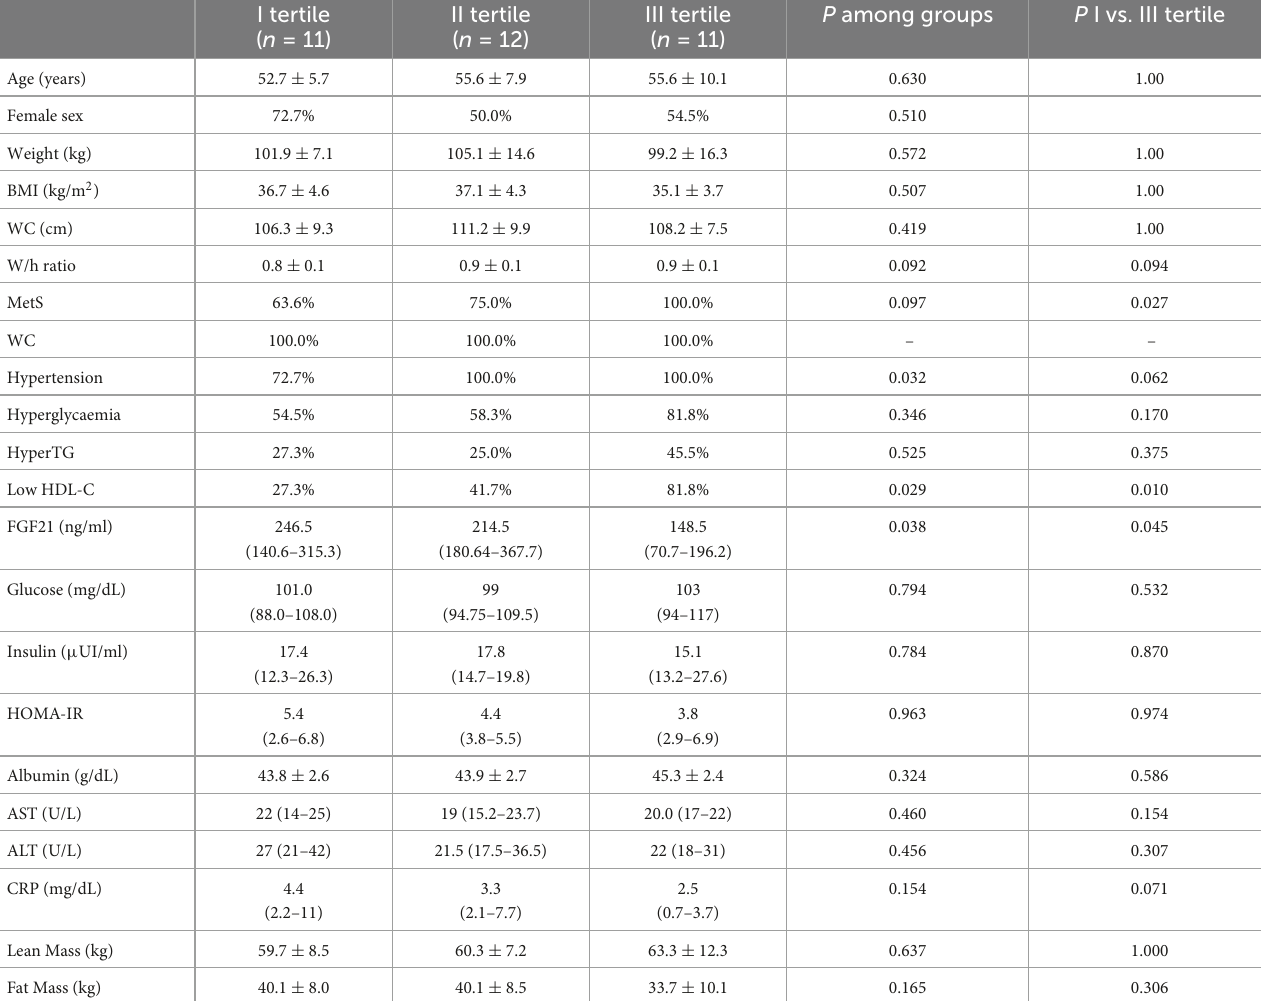
TABLE 2 Baseline clinical, biochemical characteristics and body composition of patients according to weight loss, stratified into tertiles.